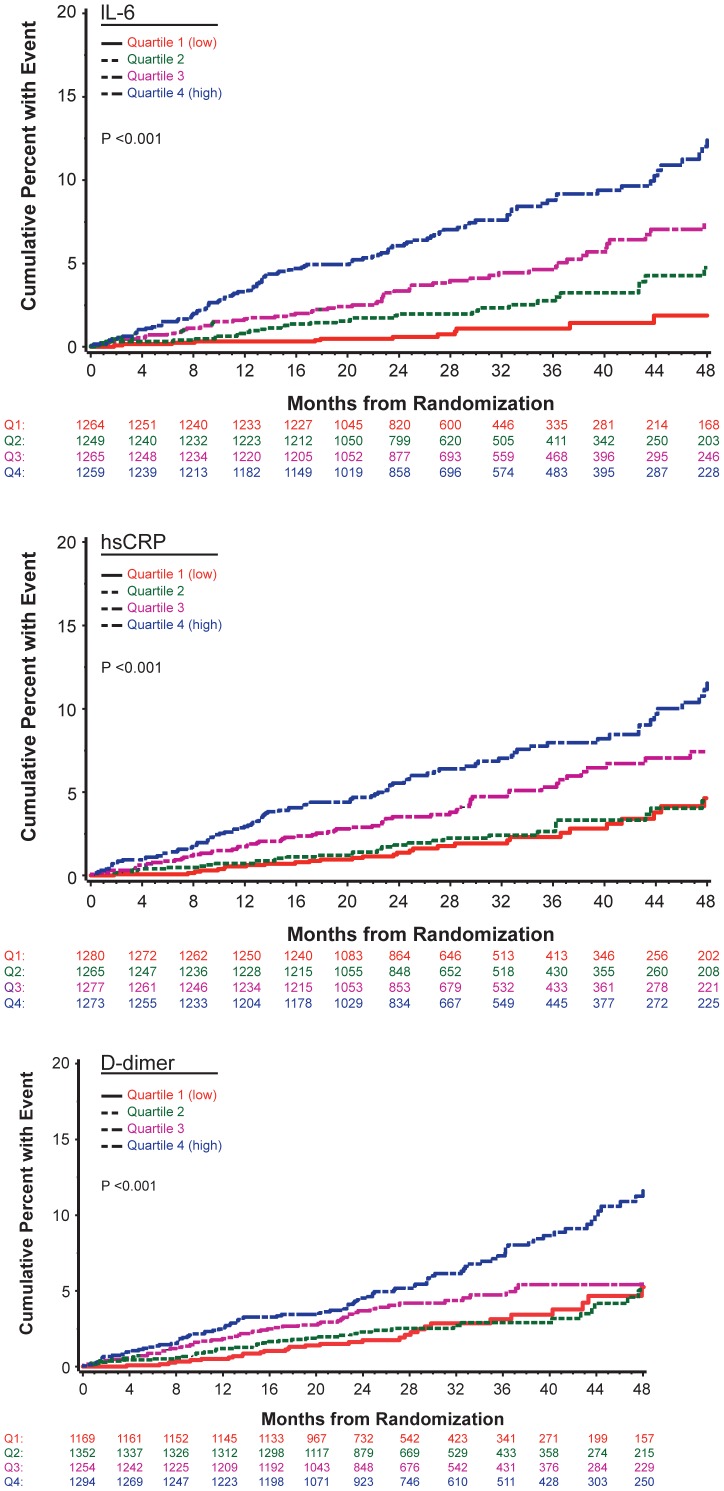
Kaplan-Meier Curves of Cardiovascular Disease (CVD) Events for Interleukin-6 (IL-6), High Sensitivity C-Reactive Protein (hsCRP) and D-dimer.Cumulative percent of participants developing CVD by quartile of IL-6 (percentile cut-off points for IL-6 quartiles are: <1.10, 1.10–1.76, 1.77–3.01, >3.01 pg/mL) (top); cumulative percent of participants developing CVD by quartile of hsCRP (percentile cut-off points for hsCRP quartiles are: <0.72, 0.72–1.71, 1.72–4.17, >4.17 µg/mL) (middle); cumulative percent of participants developing CVD by quartile of D-dimer (percentile cut-off points for D-dimer quartiles are: <0.13, 0.13–0.21, 0.22–0.37, >0.37 µg/mL) (bottom).